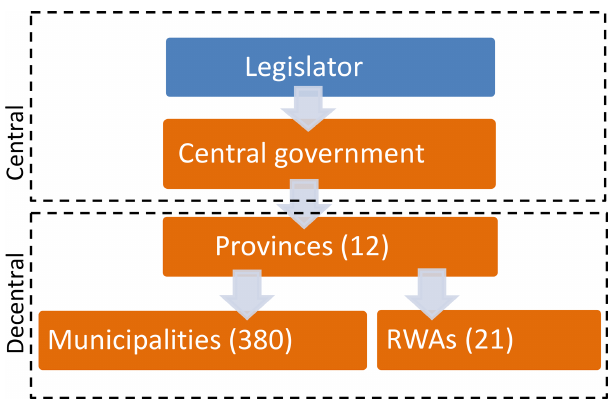
Figure 2. Constitutional organisation of the government in the Netherlands.